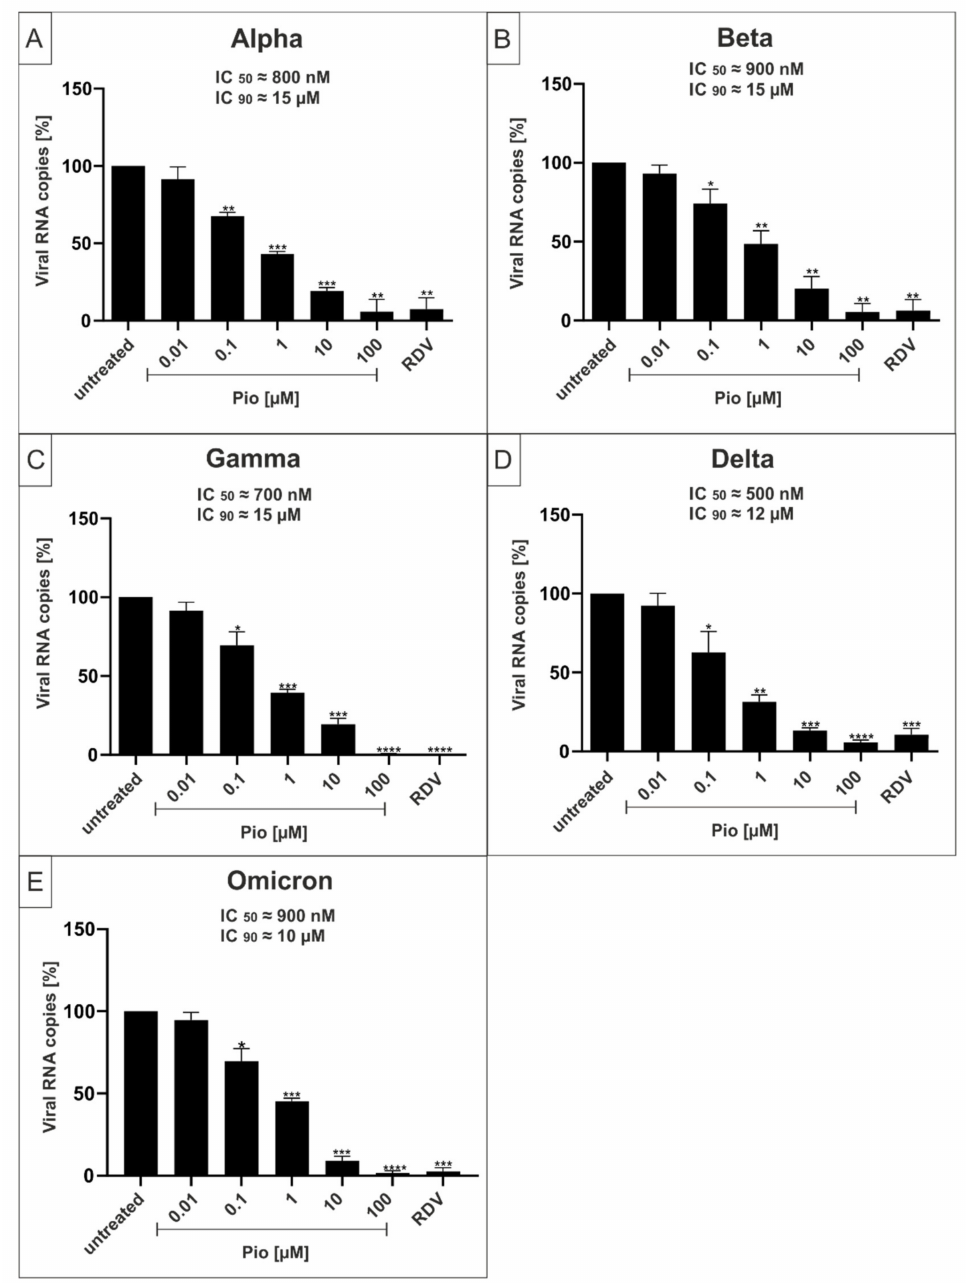
Figure 6. Pio inhibits replication of the SARS-CoV-2 VoCs Alpha, Beta, Gamma, Delta and Omicron with comparable antiviral efficacy. Calu-3 cells were infected with the SARS-CoV-2 VoCs Alpha ( A ), Beta ( B ), Gamma ( C ), Delta ( D ), and Omicron ( E ) at a MOI of 2 × 10 − 2 . One hour after infection and removal of input virus, cells were treated with the indicated concentrations of Pio; 1 µ M RDV was included as a positive control. Cell culture supernatants were harvested at 3 dpi. The virions were purified and analyzed by qRT-PCR. Data represent means of three independent experiments ± standard deviation (* p < 0.04, ** p < 0.0089, *** p < 0.0003, and **** p < 0.0001) using a One sample t test, where each value is compared to the untreated